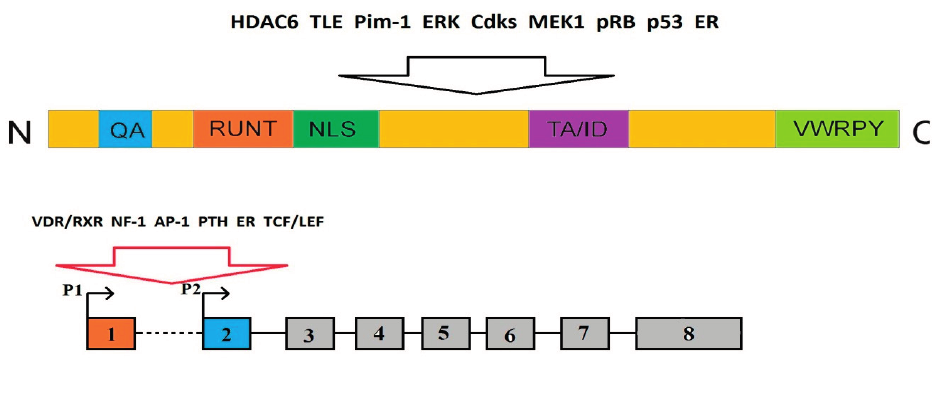
Figure 1. The structure of the RUNX2 protein ( top ) and gene ( bottom ). HDAC6, TLE, Pim-1, ERK, Cdks, MEK1, pRB, p53 and ER denote proteins interacting with RUNX2. VDR/RXR, NF-1, AP-1, parathyroid hormone (PTH), estrogen receptor (ER) and TCF/LEF (T-cell factor/lymphoid enhancer factor) are factors interacting with the RUNX2 gene promoter. NLS: nuclear localization signal peptide; RUNT: the runt domain; P1 and P2: alternative promoters, numbers in boxes denote exons; QA: polyglutamate and alanine motif; TA/ID: transactivation/inhibitory domain; VWRPY: C-terminal repression motif; VDR/RXR: vitamin D receptor/retinoic acid X